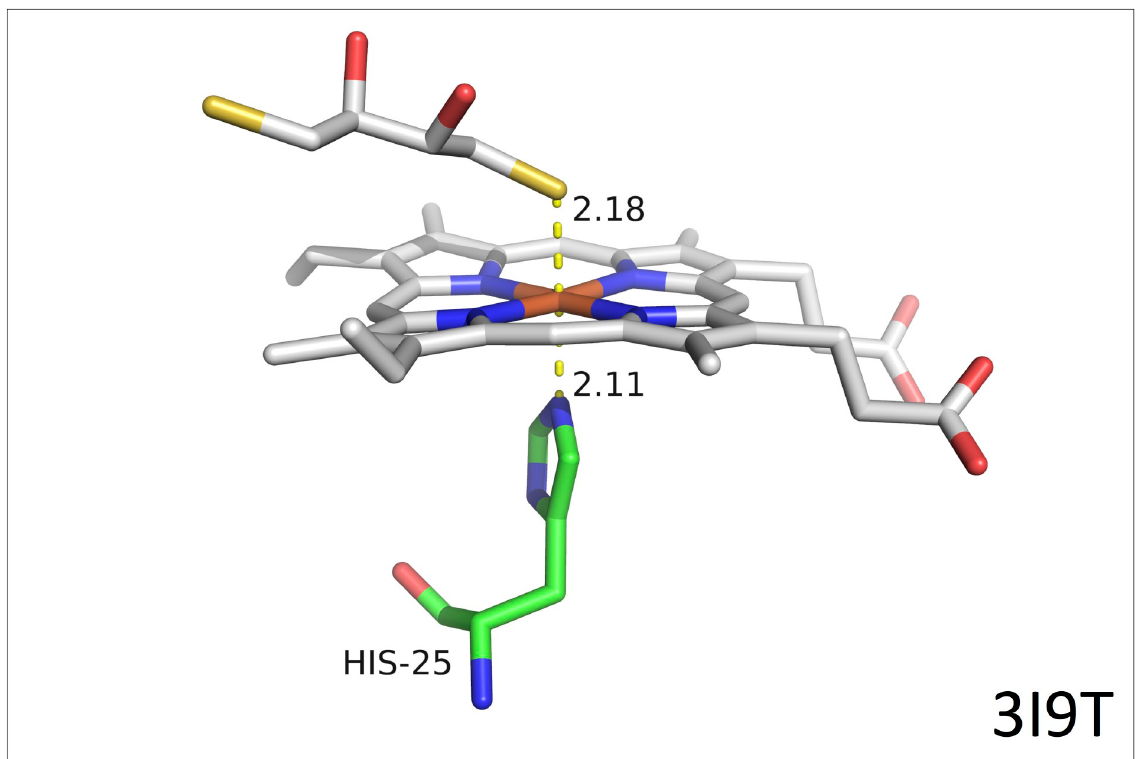
Fig 3. 3I9T crystal structure. Heme group, His 25 and DTT from the 3D structure of DTT binding to rat heme oxygenase (PDB entry 3I9T [36]).